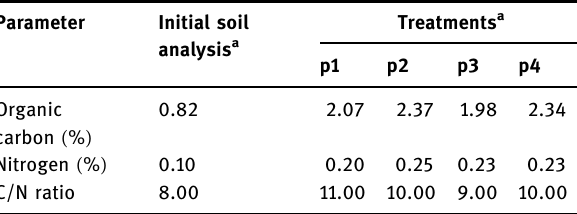
Table 1: Chemical properties of fertilized plot with di ff erent types of organic manure Parameter